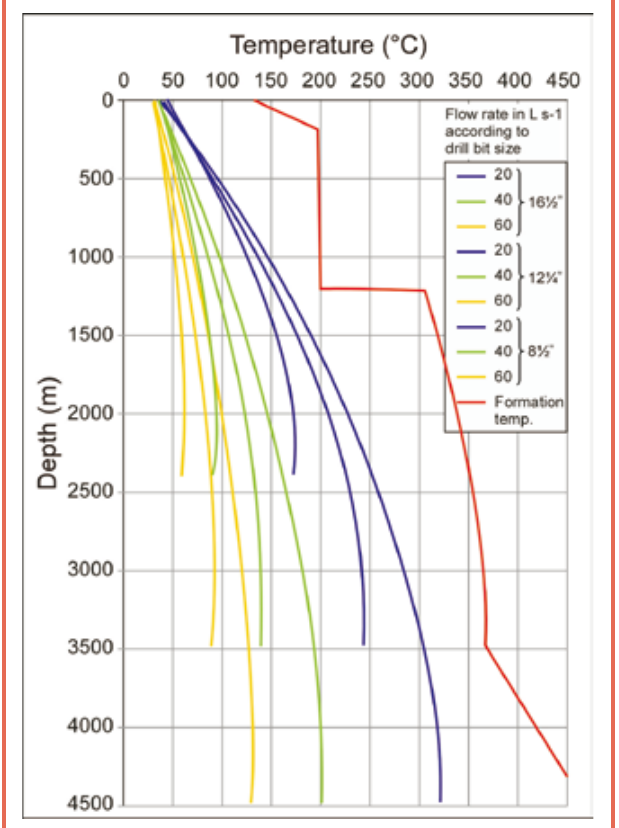
Figure 1. The anticipated temperature scenarios which any core barrel design has to water flushing. Figure 1 suggests that a minimum flushing capacity of 30–40 L s -1 will have to be maintained for all of the tripping time and preferably for at least some of the coring time.